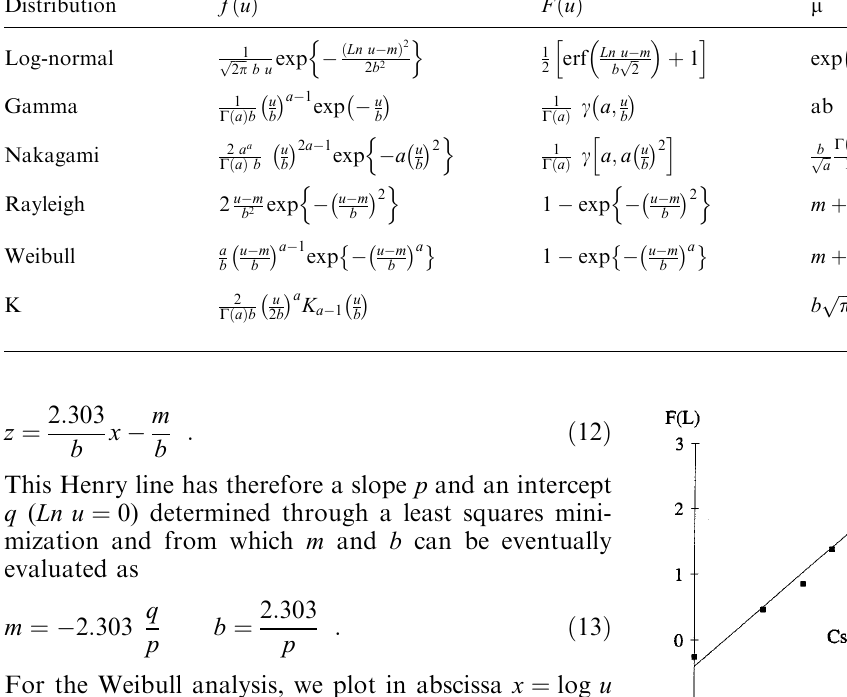
Table 3. Some usual statistical distributions Distribution